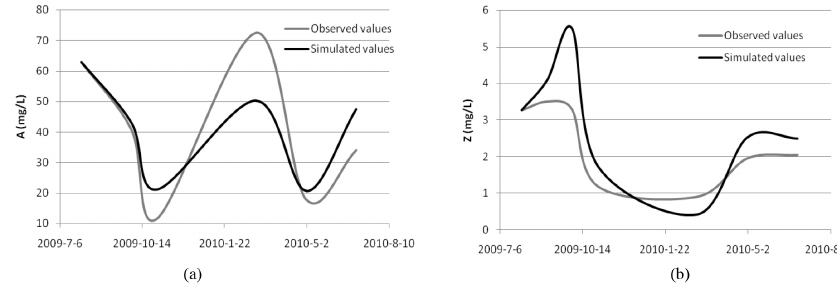
Figure 16. Validation results for phytoplankton biomass (a) and zooplankton biomass (b) at site